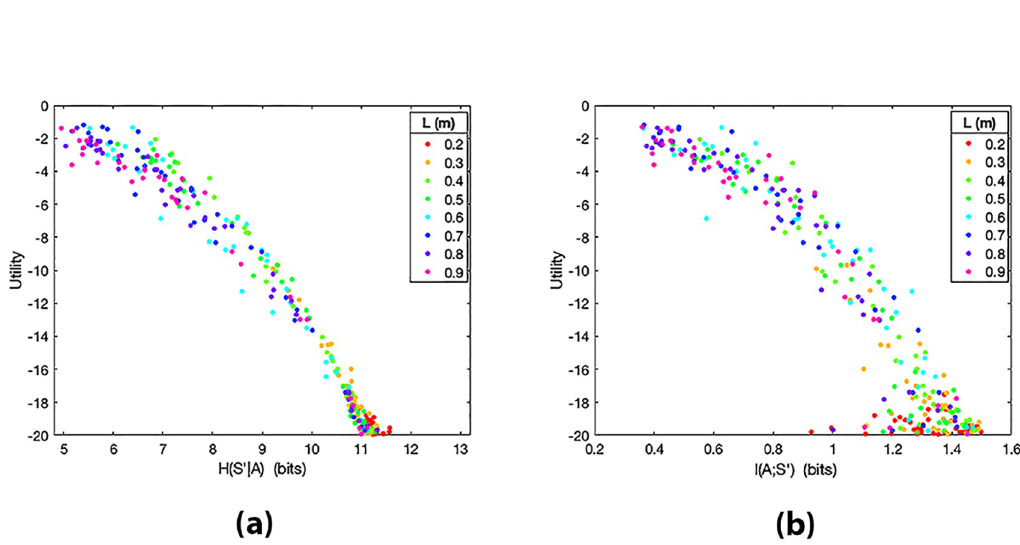
Fig 5. Utility U i of trials i during the balancing task plotted as a function of H ( S 0 i | A i ) in (a) and of I ( A i ; S 0 i ) in (b), for all participants and pendulum lengths L . (a) Spearman correlation ρ = − 0.979. (b) ρ = − 0.907.